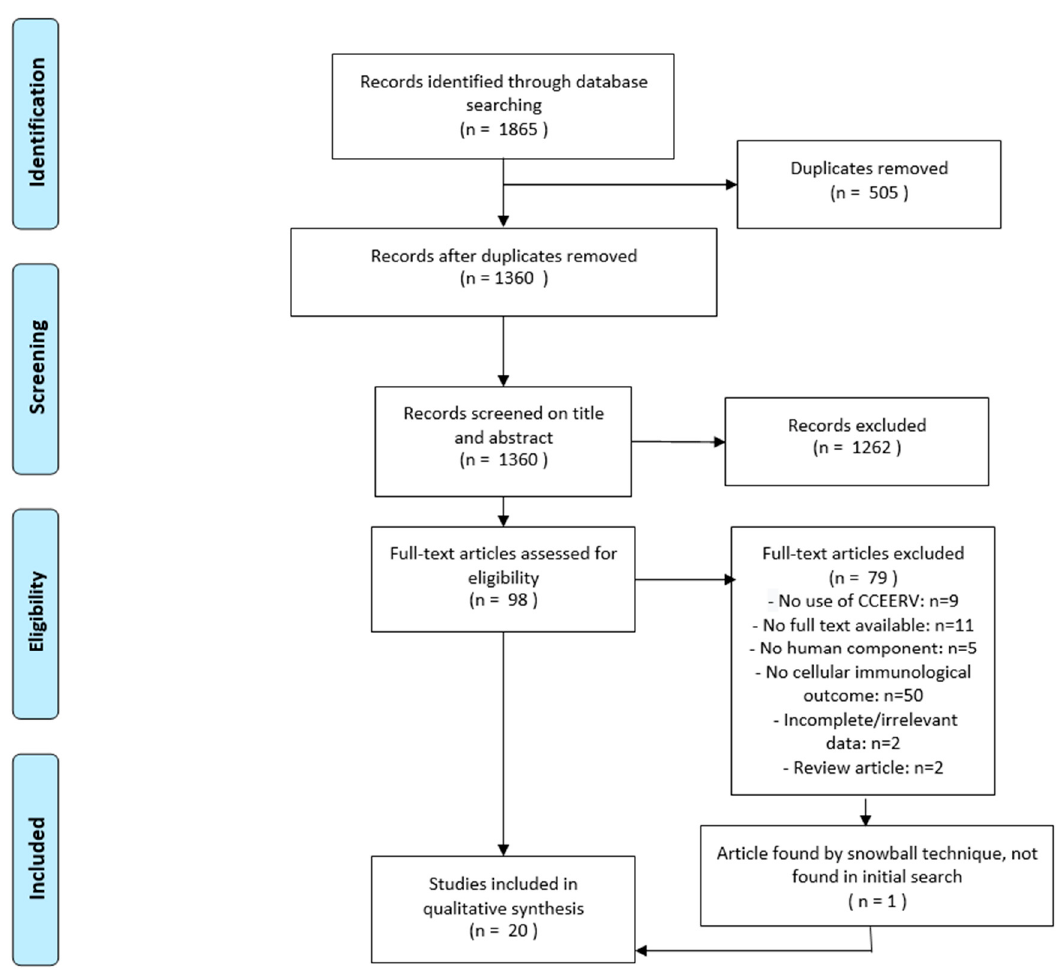
Figure 1. Flowchart describing the study selection process. CCEERV = cell-culture or embryonated egg-based rabies vaccines.